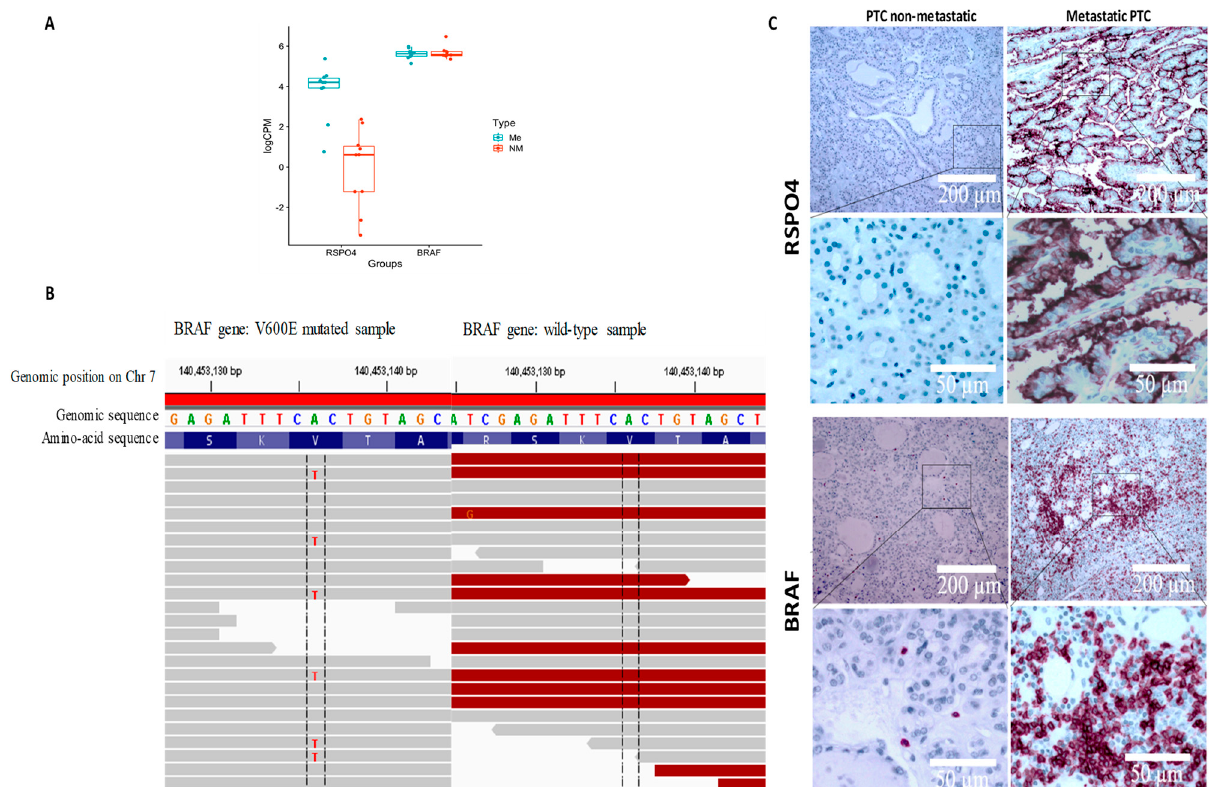
Figure 5. RSPO4 and BRAF genes and proteins were highly expressed in our metastatic cohort ( A ). Using Integrative Genome Viewer (IGV) all the 10 metastatic samples harboured an A to T substitution at position 140,453,136 on chromosome 7, that is harbouring a BRAF V600E classical mutation ( B ). Protein expression levels reveled that BRAF and RSPO4 are overexpressed in PTC samples with locoregional invasiveness ( C ).